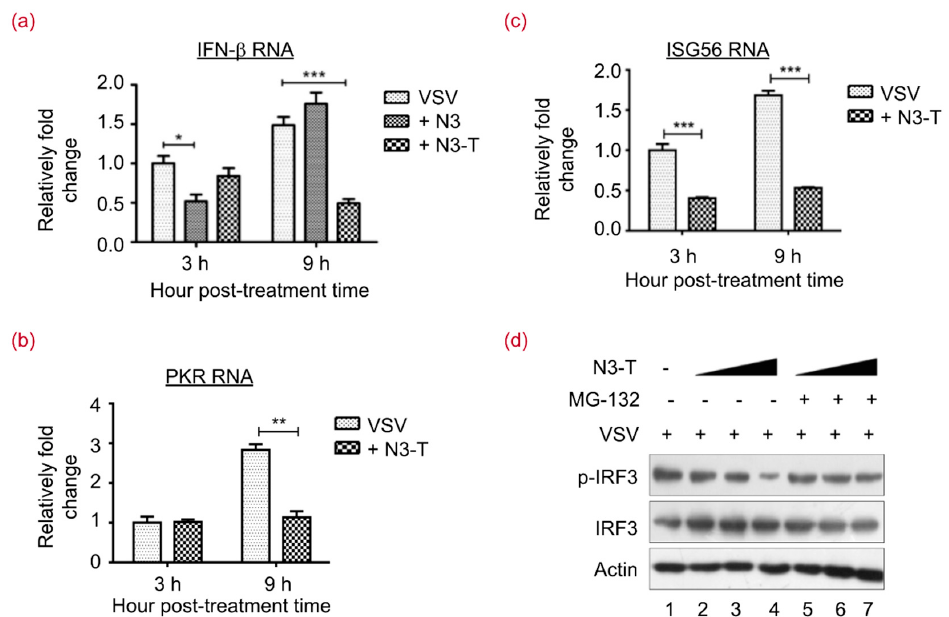
Figure 5. N3-T Suppresses Type I IFN Antiviral Responses. ( a – c ) HEK293T cells were infected with VSV at 0.1 MOI for the indicated time in the presence of PBS, N3 (20 µg/mL), or N3-T (20 µg/mL). Total RNAs were isolated and expression levels of IFN- β ( a ); PKR ( b ); and ISG56 ( c ) mRNAs were quantified by real-time polymerase chain reaction (RT-PCR) and normalized to that of glyceraldehyde-3-phosphate dehydrogenase (GAPDH). The bar graphs show the means with standard deviations (SD) of triplicate repeats of one representative experiment. * p < 0.05, ** p < 0.01, *** p < 0.001; ( d ) HEK293T cells were infected with VSV at 0.1 MOI for 24 h in the presence of PBS or increasing doses of N3-T (0, 10, 20 µg/mL). The cells were treated with DMSO (lanes 2–4) or MG-132 (lanes 5–7) for 6 h before collection. Cell lysates were analyzed by immunoblotting with antibodies against p-IRF3 and IRF3. Actin served as the loading control .